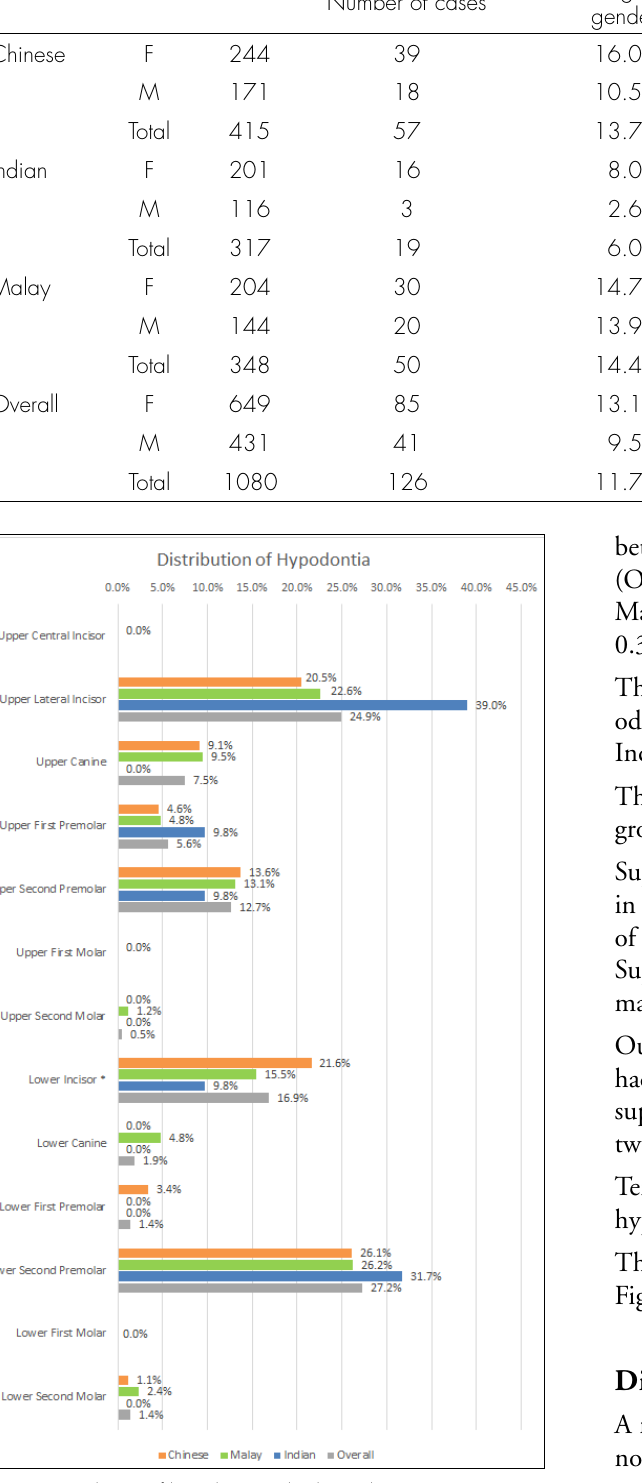
Figure 2. Distribution of hypodontia in the three ethnic groups.